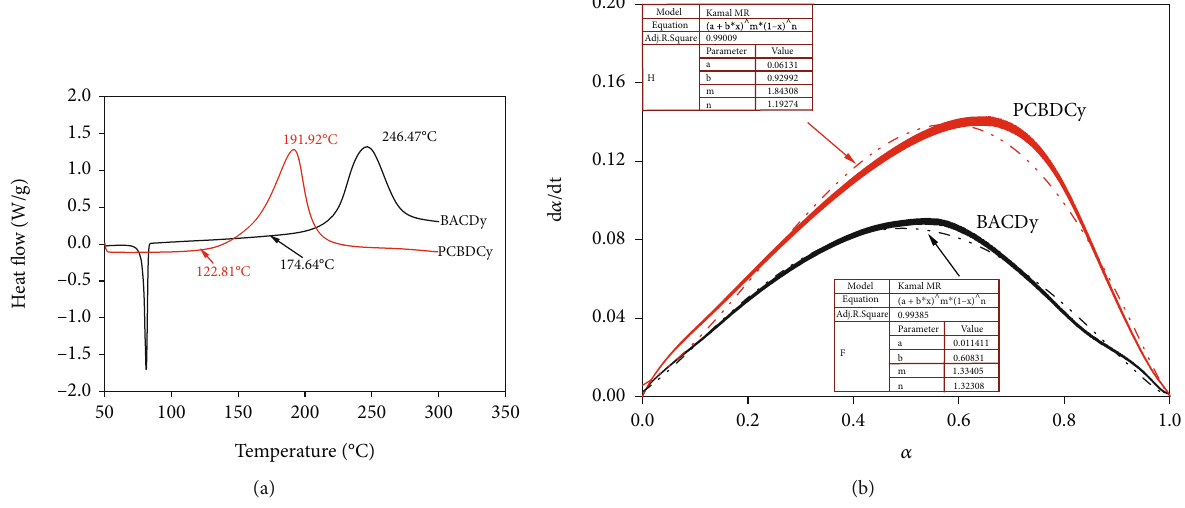
Figure 3: DSC curves and simulations of the nonisothermal curing reaction of PCBDCy and